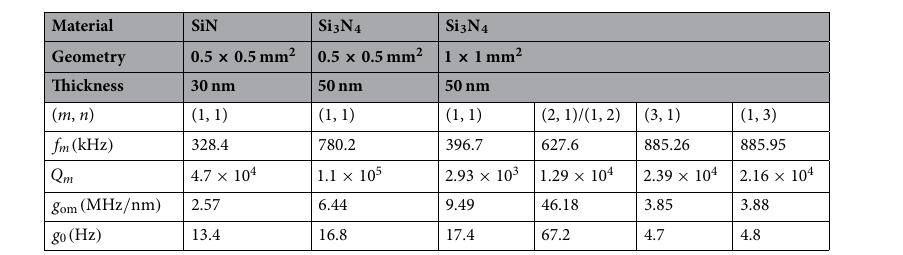
0.5mm 2 30 nm ), ( b ) Si 3 N 4 × ×